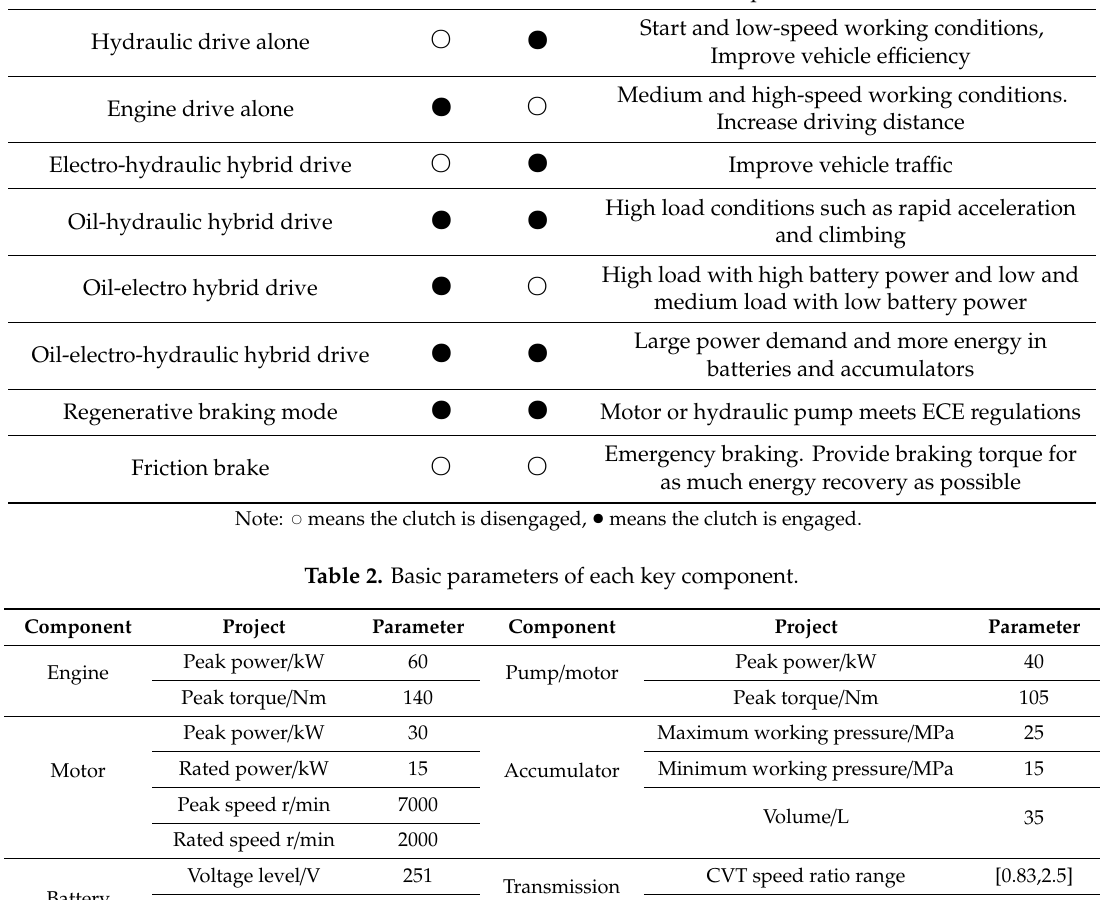
Figure 1. Structure of oil–electric–hydraulic hybrid power system. Table 1. Working modes of the hybrid system.